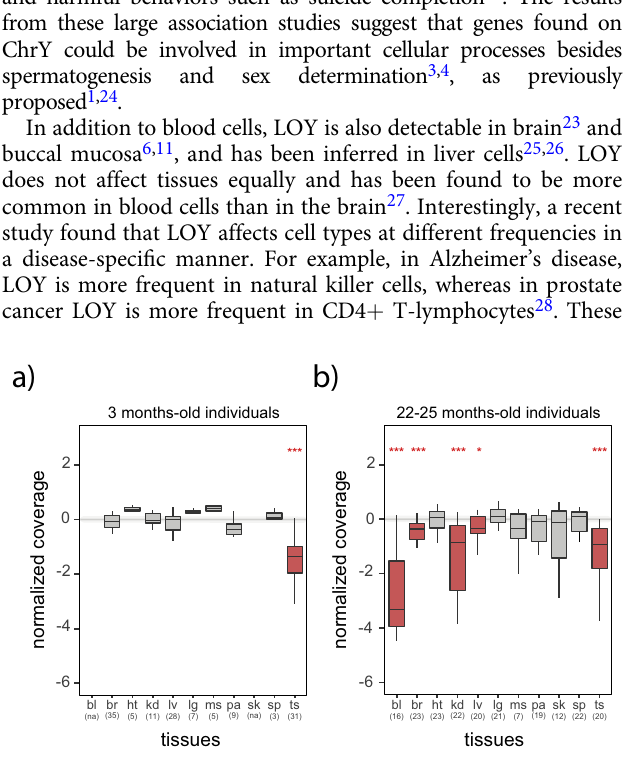
Fig. 1 Normalized copy number of EIF2S3Y in eleven tissues from young and old rats. a Coverage of EIF2S3Y normalized by the coverage of the autosomal gene COL1A1 in nine tissues of three months old rats (data from blood and skin were inadvertently lost; see Methods). b Coverage of EIF2S3Y normalized by the coverage of the autosomal gene COL1A1 in eleven tissues of 22 – 25 months old rats. a , b bl is blood, br is brain, ht is heart, kd is kidney, lv is liver, lg is lung, ms is muscle, pa is pancreas, sk is skin, sp is spleen, ts is testis. Signi fi cant differences, Mann – Whitney U test against a distribution with a fi xed median of 0 (no difference against expected estimates). P values were Benjamin – Hochberg corrected: * indicates P < 0.05; *** indicates P < 0.001. Sample sizes are indicated in parenthesis. Error bars, maximum and minimum values, excluding